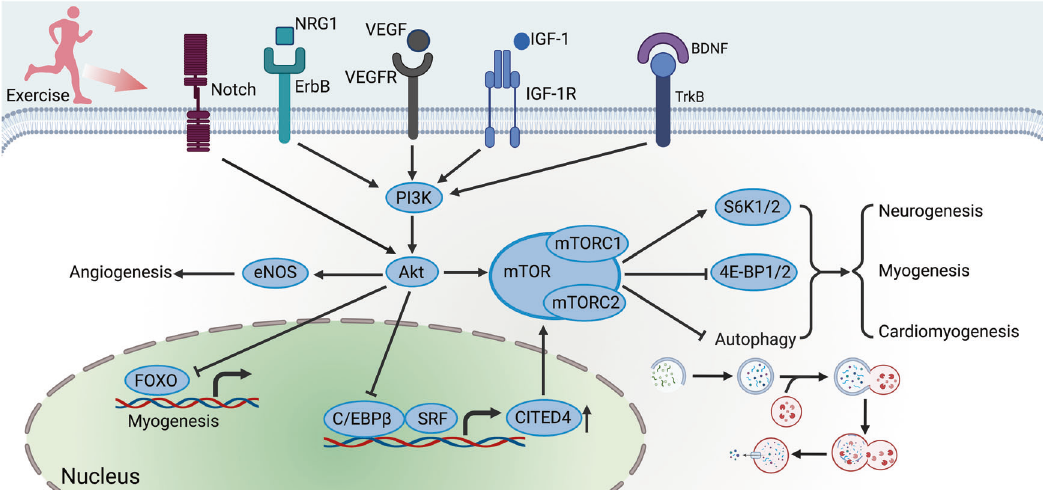
Fig. 3 PI3K/Akt signaling pathway. The PI3K/Akt pathway is mainly activated by an array of growth factors, such as IGF-1, NRG1, VEGF, and BDNF. Akt can be directly activated by Notch signaling. The PI3K/Akt pathway mainly acts as the upstream of mTOR activation. The activation of mTOR promotes cardiomyogenesis, myogenesis, and neurogenesis via various signaling. Importantly, PI3K/Akt axis inhibits C/EBP β , thus upregulating CITED4 to activate mTOR and promoting myogenesis. Additionally, the PI3K/Akt axis inhibits FOXOs, promoting myogenesis. eNOS is upregulated by the PI3K/Akt axis, promoting angiogenesis. Created with